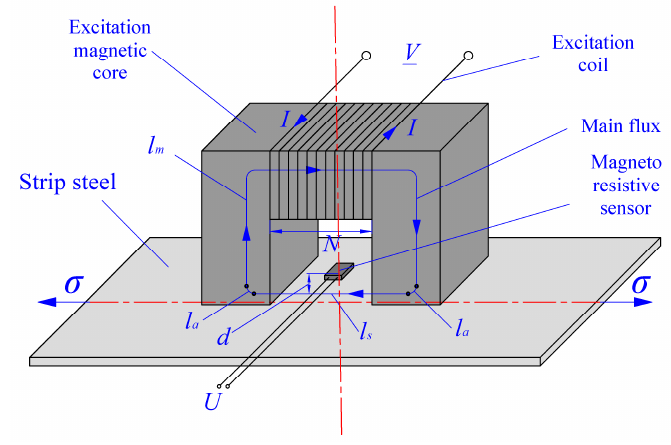
Figure 1. Basic schematic diagram for stress detection of strip steel.